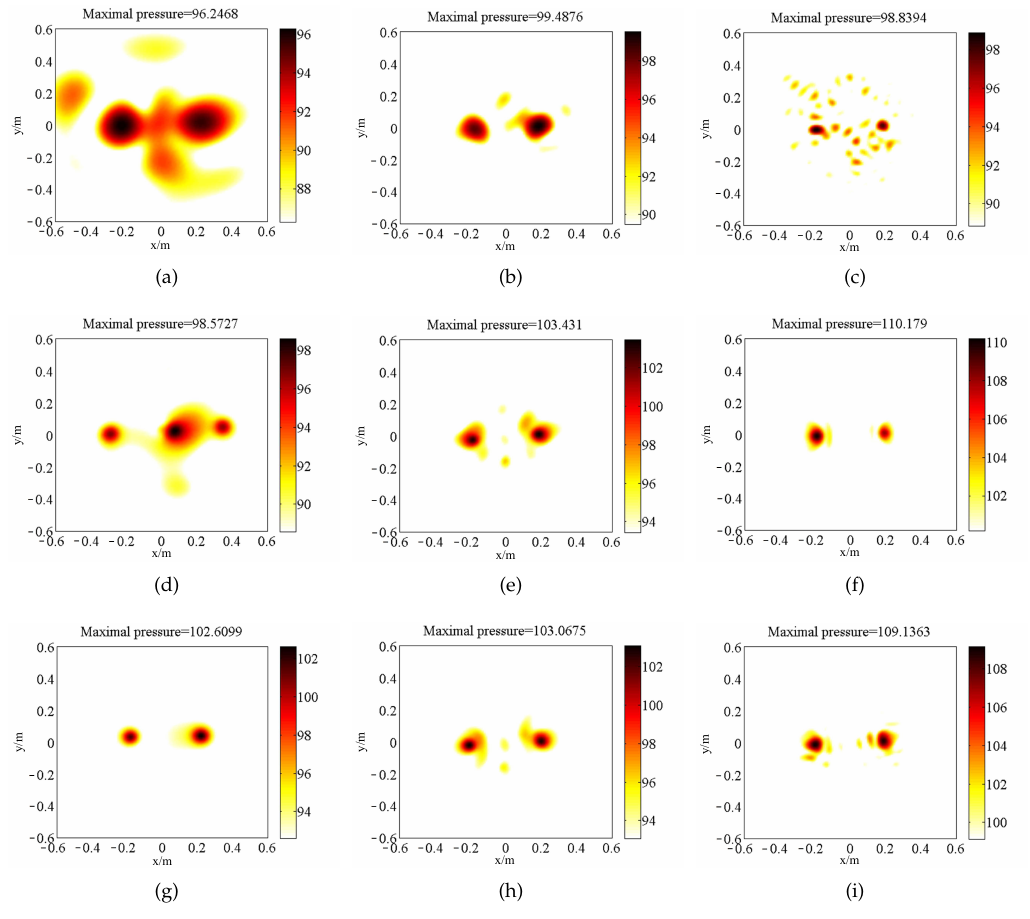
Figure 10. The sources reconstructed for near-field by CESM, WBH, and BI-AI (with unit of dB, 100 dB = 2 Pa): ( a ) CESM, 500 Hz; ( b ) CESM, 1500 Hz; ( c ) CESM, 3000 Hz; ( d ) WBH, 500 Hz; ( e ) WBH, 1500 Hz; ( f ) WBH, 3000 Hz; ( g ) BI-AI, 500 Hz; ( h ) BI-AI, 1500 Hz; ( i ) BI-AI, 3000